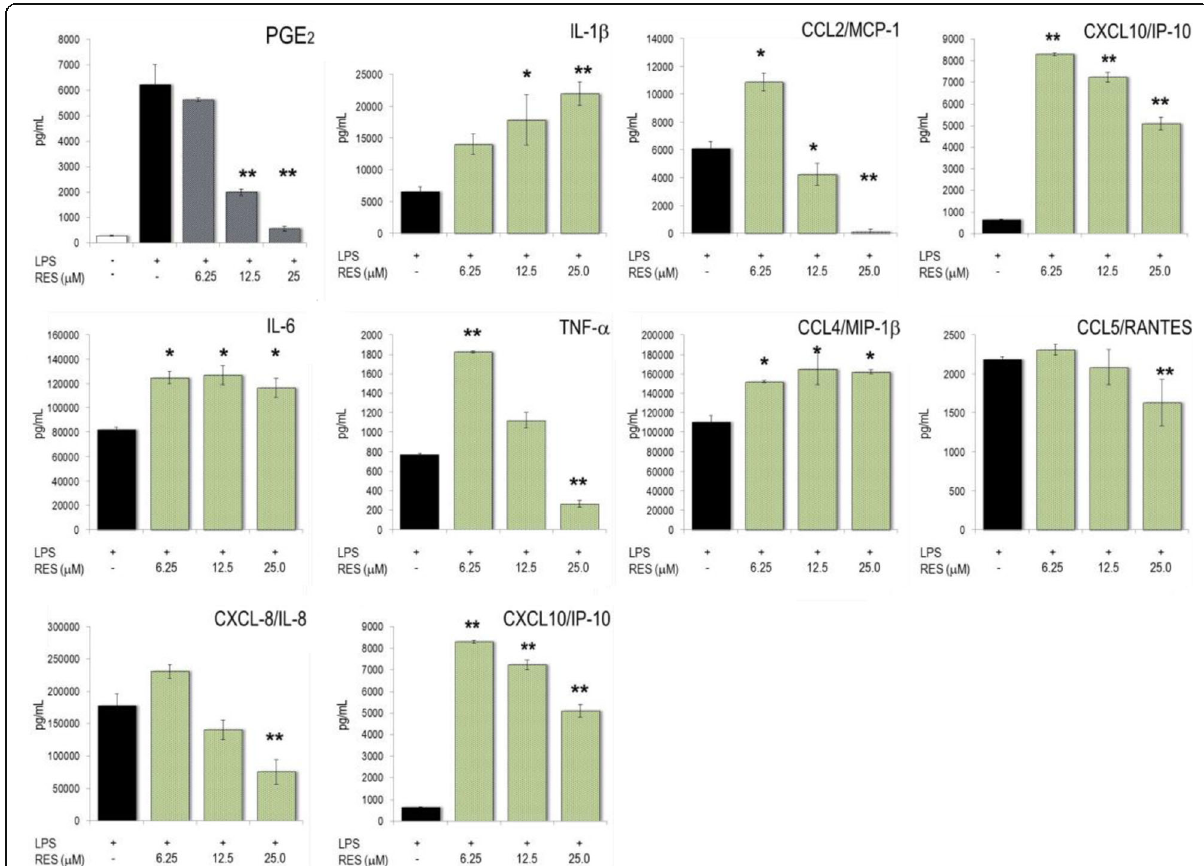
Fig. 4 RES altered the production of inflammatory mediators in activated PBLs. Freshly isolated PBLs were incubated with substances, stimulated with LPS and cultured for 24 h. The mediators were determined in cell culture supernatants. Results (± SEM) obtained from cultures of PBLs from three donors are given. * p < 0.05, ** p < 0.01 (versus LPS-stimulated cells)